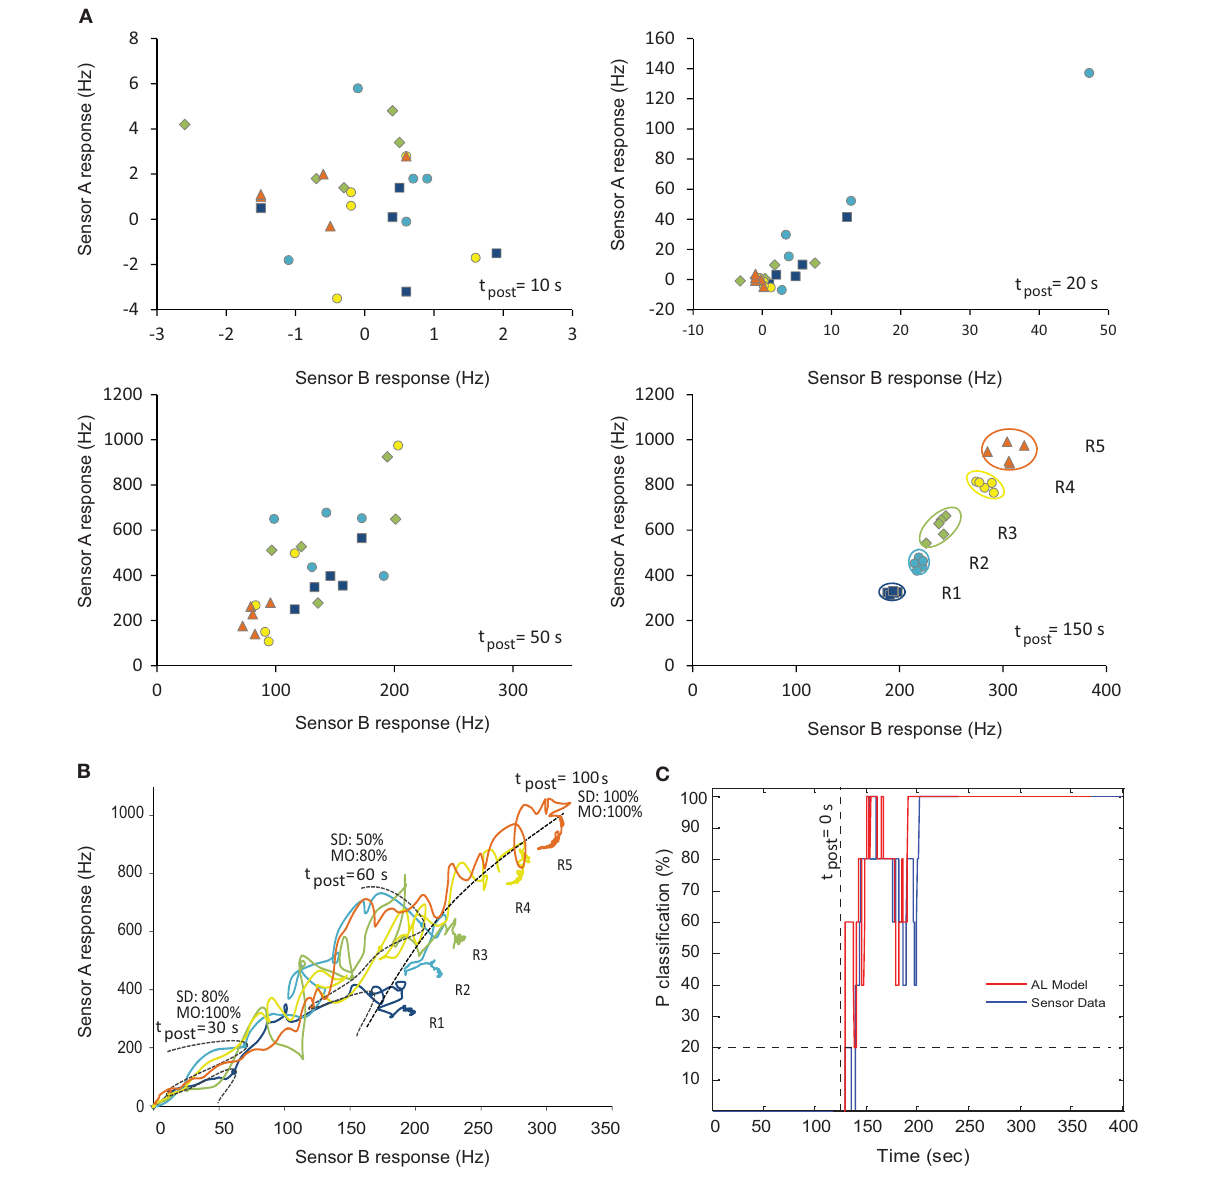
the sensor data (SD) and model output (MO). (C) Real-time classification probability ( P classification ) of raw sensor data compared with MGC AL model outputs over time. During the early transient phase of the chemosensor input ( t post < 100s post-stimulus), AL model output can be classified more robustly above chance compared with raw chemosensor input. As correct classification requires 1-of-5 categories, all with equal priors, chance level is 20% (shown by horizontal dashed line). R1, R2, ...R5 represent distinct chemical ratios (see Table 1